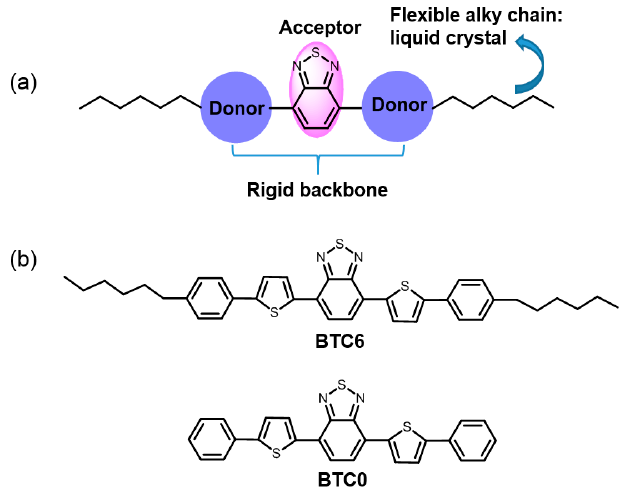
Figure 1. Molecular design of D- π -A molecules based on benzodiathiazole moiety ( a ) and chemical structures of the model compounds 4,7-bis (thiophen-2-yl) benzo[c][1,2,5]thiadiazole derivative (BTC0) and 4,7-bis(thiophen-2-yl)benzo[c][1,2,5]thiadiazole derivative with a simple introduction of hexyl groups (BTC6) ( b ).